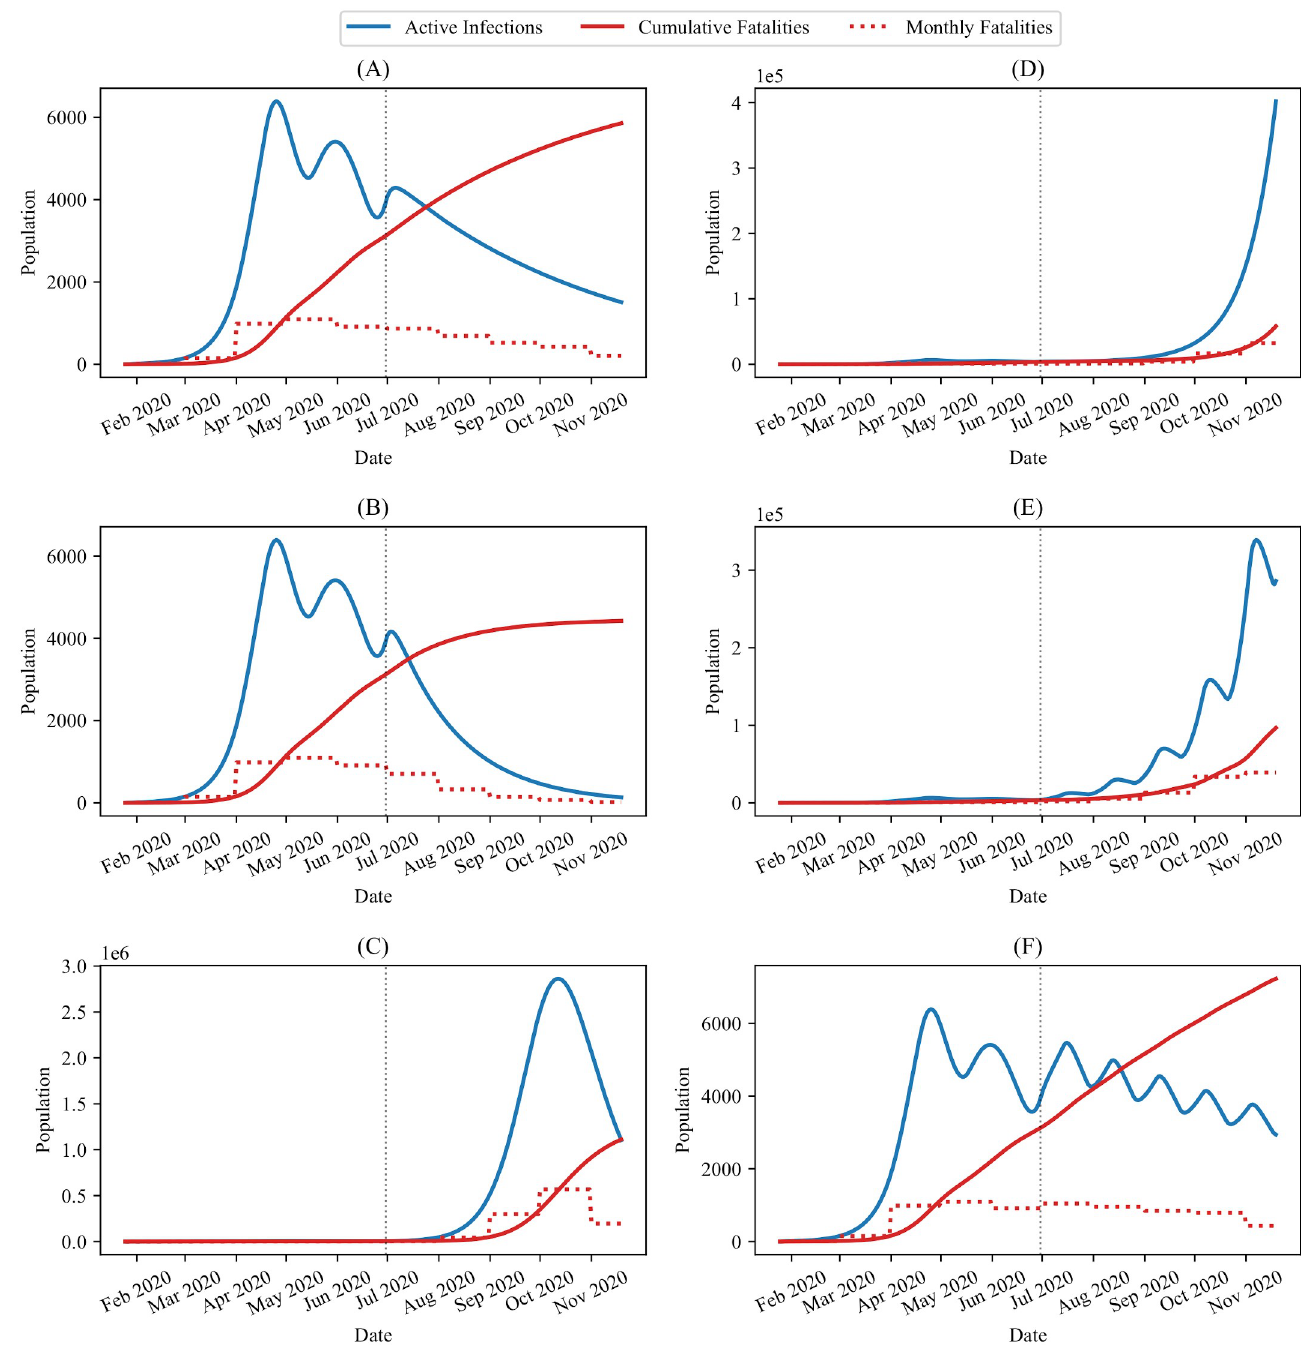
Fig 5. Potential public response model predictions. Possible future ( t > t values and initial conditions are given in Table 1. The blue lines represent the active number of infections, the solid red lines represent the cumulative number of (daily) deaths, and the dashed red lines represent the monthly fatalities. The vertical dashed line is placed at June 30th to differentiate between past and future data. The different future θ ( t ) schedules are: (A) Maintain a constant θ ( t > t θ ( t > t n ) with a half-life of two months, (E) Pulse θ ( t > t n ) between 0 and 0.8 every two weeks, (F) pulse θ ( t > t n ) between 0.4 and 0.8 every two weeks.